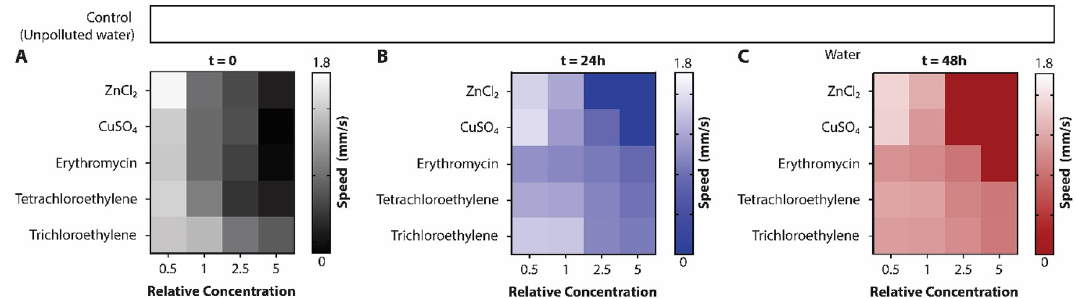
Figure 4. Swimming speed of Paramecia in all the pollutants tested. ( A ) Swimming speed immediately after their mixing in the contaminated samples. ( B ) Speed after 24 h in the contaminated sample. ( C ) Swimming speed 48 h in the contaminated samples. White is the average swimming speed of the Paramecia in the unpolluted reference